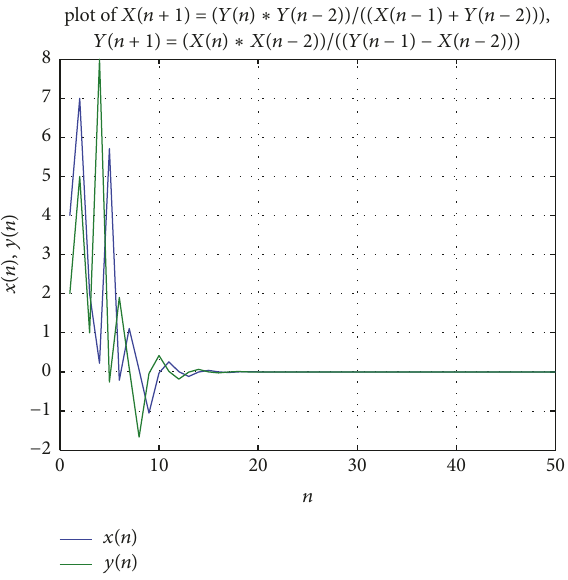
Figure 4: This figure shows the solution of